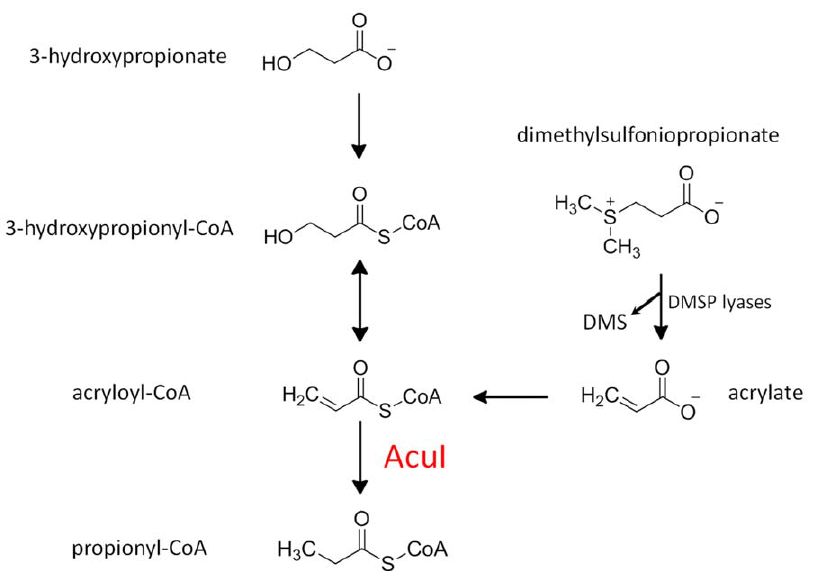
Figure 5. AcuI-mediated conversion of acryloyl-CoA to propionyl-CoA. The pathway from 3-hydroxypropionate to propionyl-CoA is adapted from Schneider et al. [13]. Also shown is how DMSP lyases can generate acrylate, which is postulated to be converted to acryolyl-CoA by a CoA-ligase, as yet unidentified. The exact identity of the DMSP lyase is strain-dependent; e.g., Rhodobacter sphaeroides has the DddL lyase, and in Ruegeria pomeroyi , the acrylate can be generated from DMSP by DddP, DddQ and/or DddW.